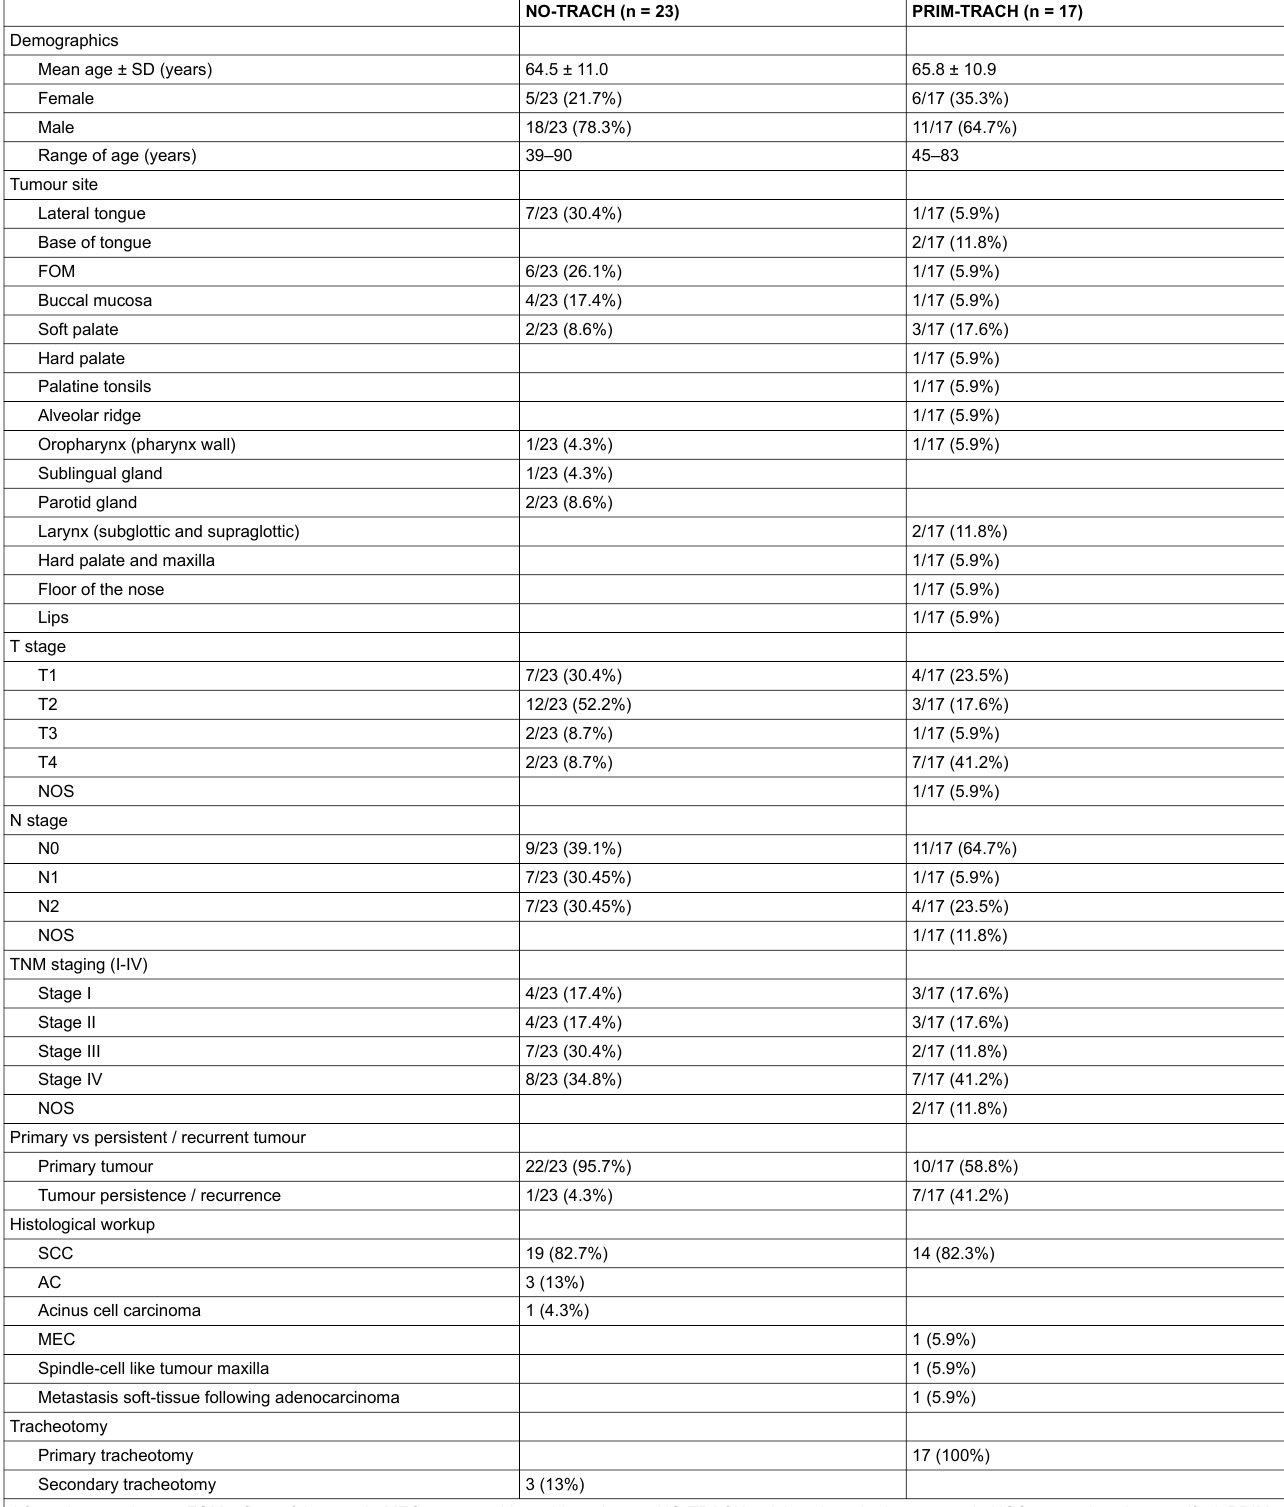
Table 1: Patient demographic data and tumour characteristics for each